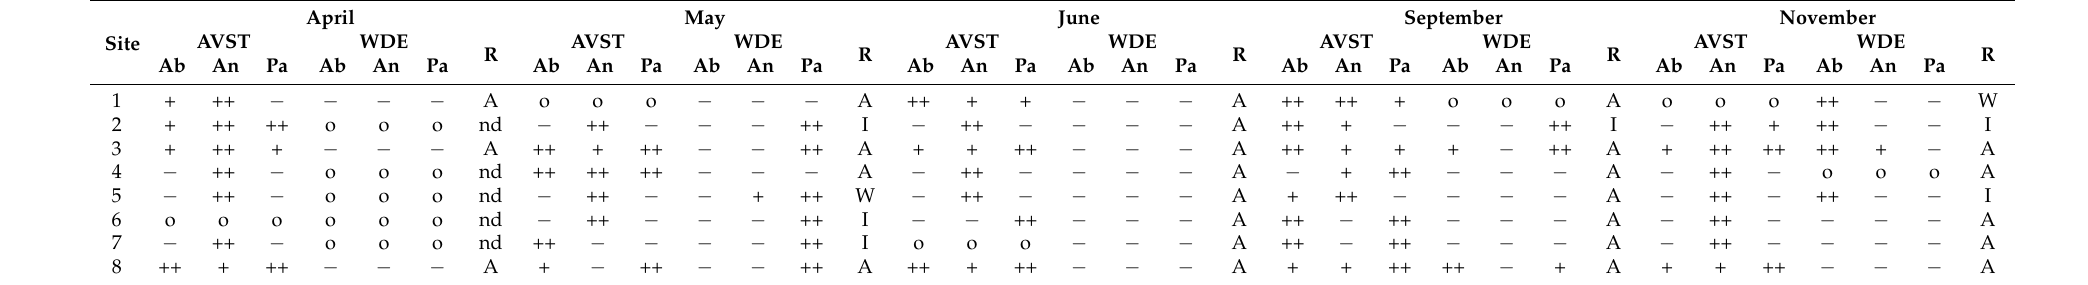
Table 3. Comparison of the suitability of automatic volumetric spore trap (AVST) and wood disc exposure method (WDE) for the detection of airspora composition of H. annosum s.l. − , target not detected; o, H. annosum s.l. detected but not identified at the species level; +, target present in lower concentration than other target species; ++, target had the highest concentration among all target species; R, result of the comparison; nd, not determined because identification at the species level was not attempted in the case of WDE; A, AVST was more sensitive; W, WDE was more sensitive; I, inconsistent species